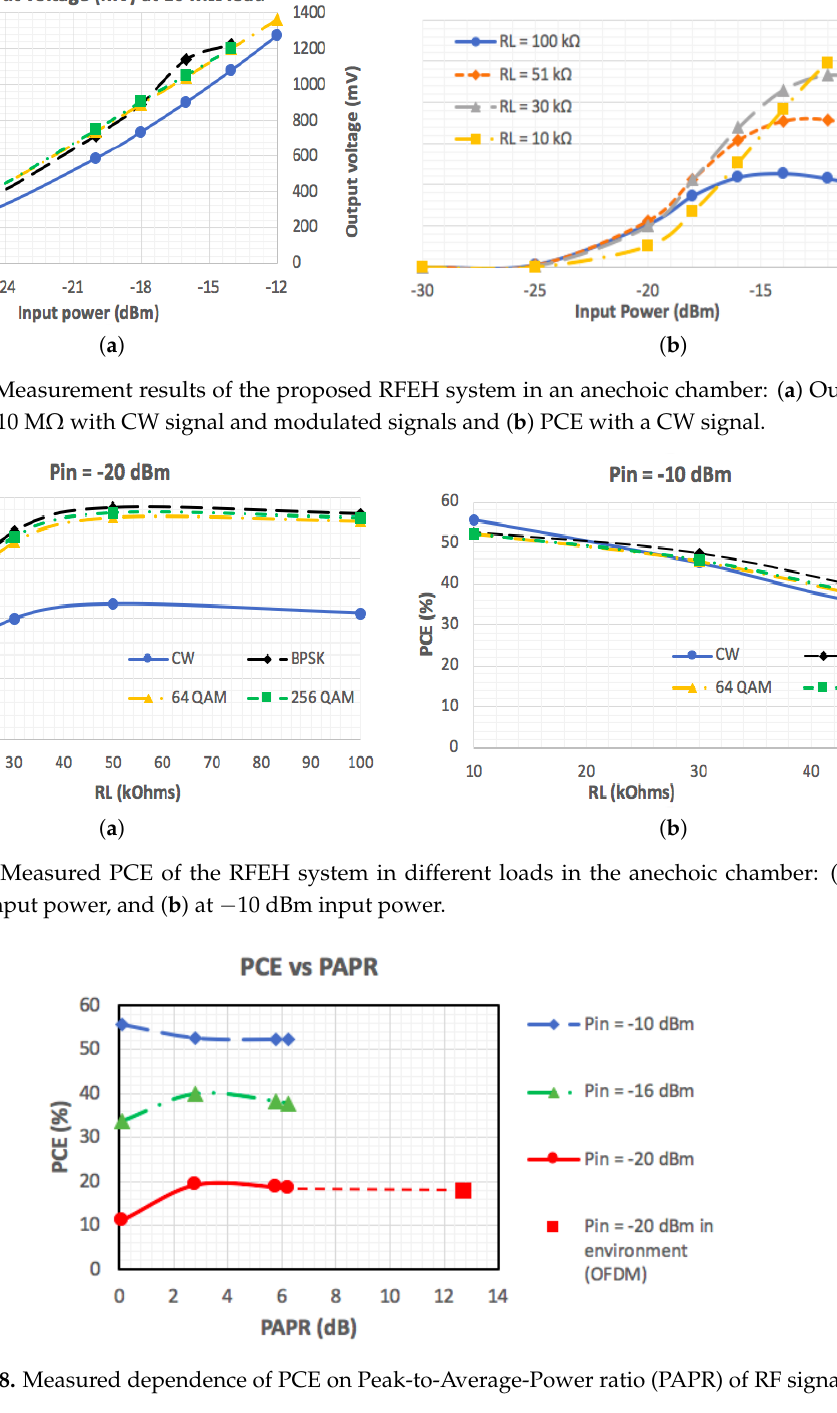
Figure 18. Measured dependence of PCE on Peak-to-Average-Power ratio (PAPR) of RF